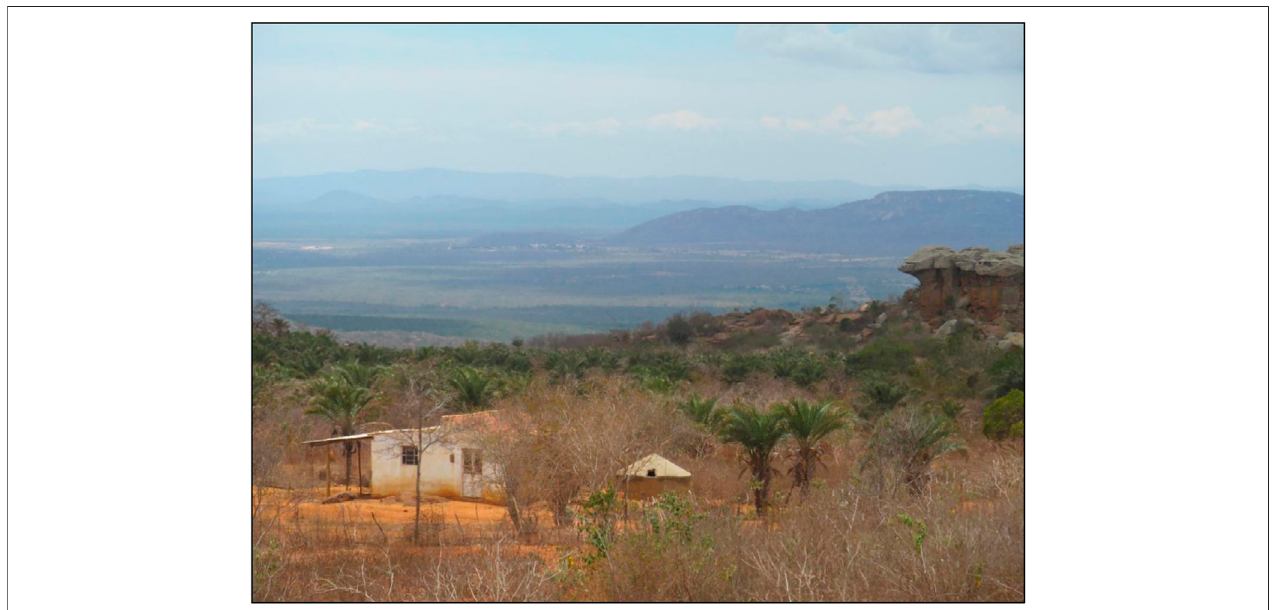
FIGURE 2 | Landscape of Igrejinha, rural community located in the Catimbau National Park (Pernambuco State, semiarid region of Northeastern Brazil). Photo: Henrique F. Magalhães.